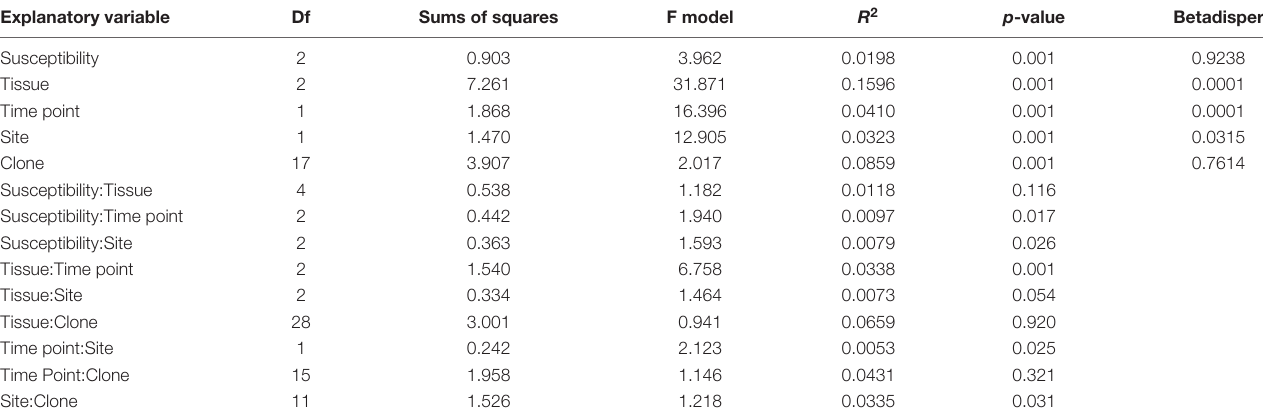
TABLE 4 | Factors explaining fungal community composition in ash. Explanatory variable Df Sums of